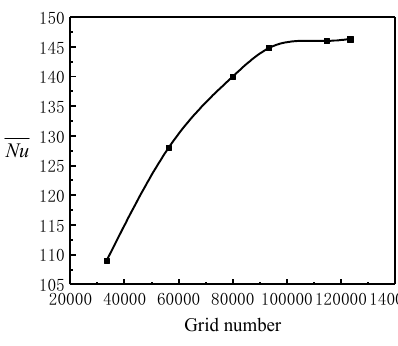
Figure 2. Meshing generation.